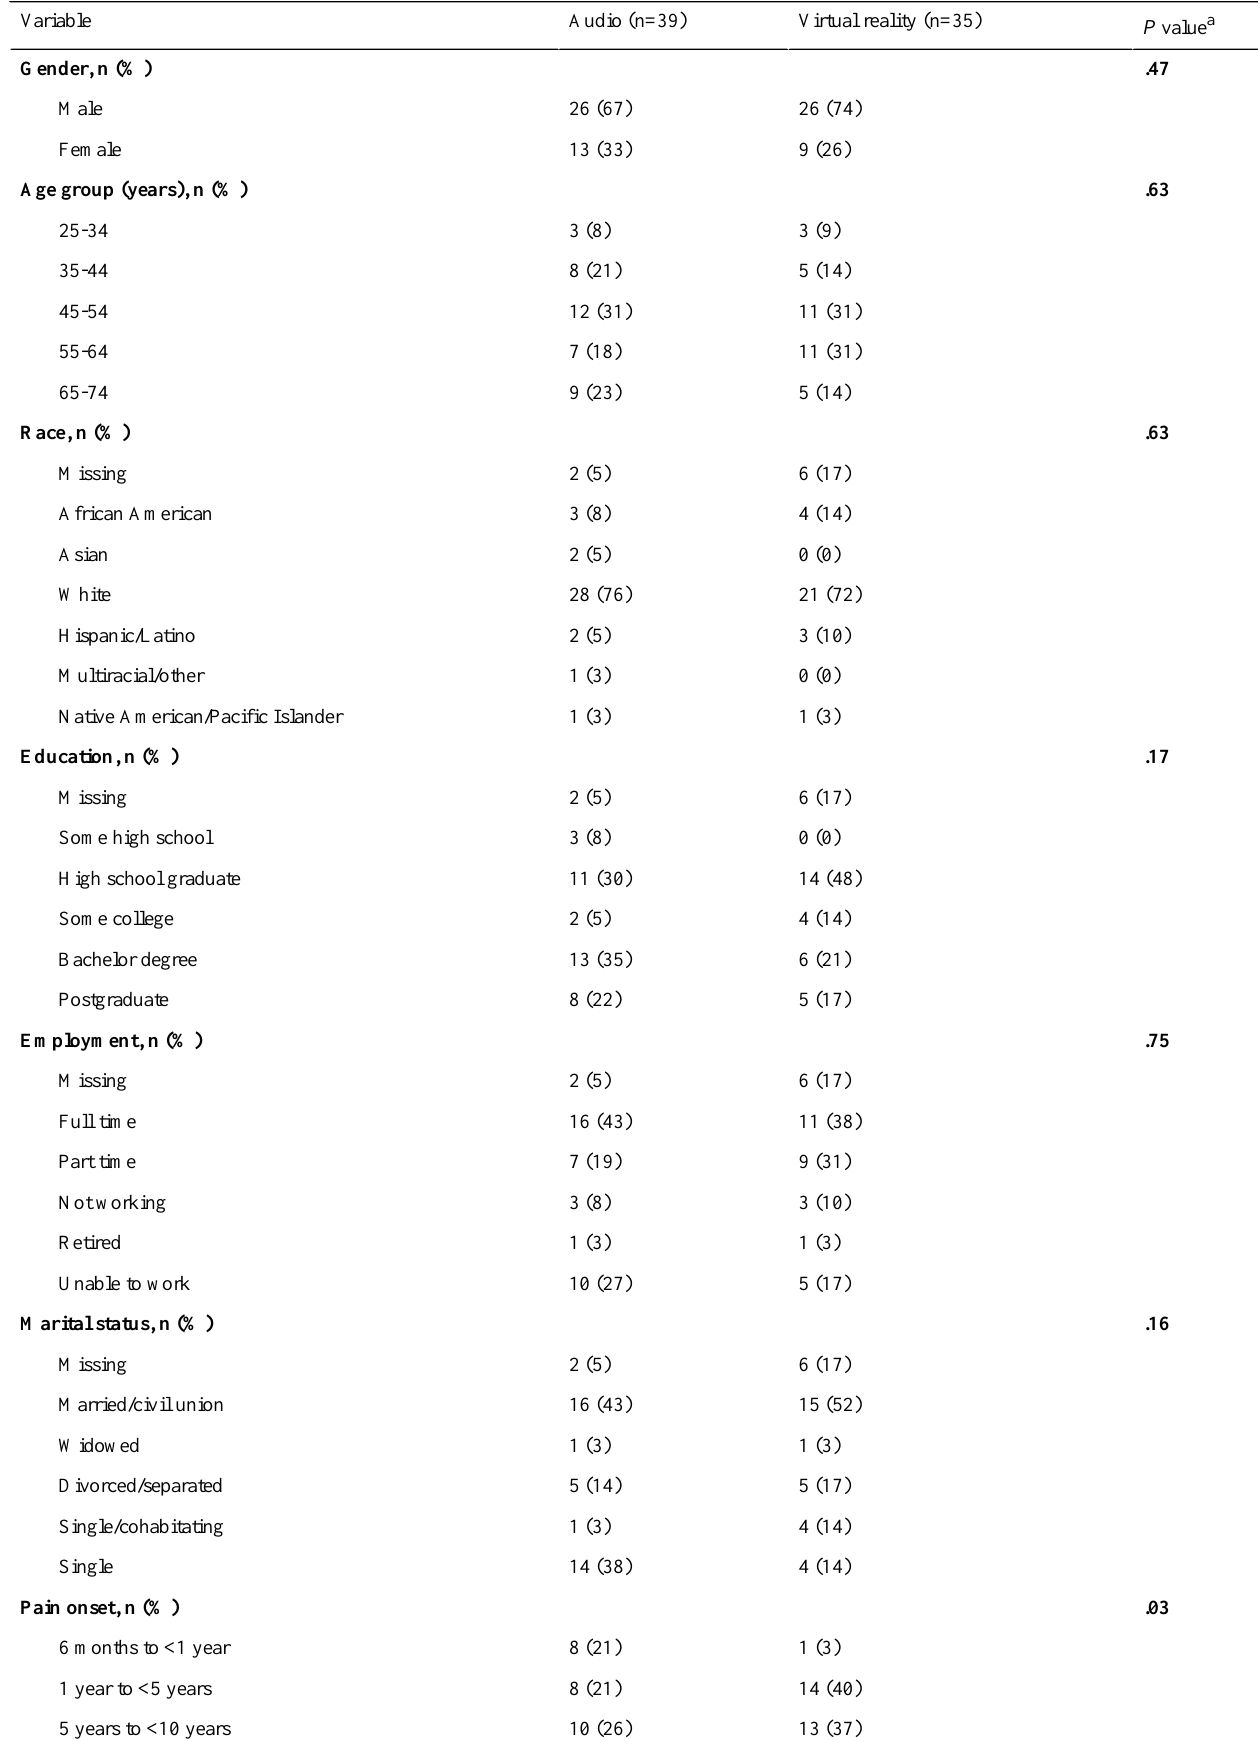
Table 1. Participant characteristics by treatment group